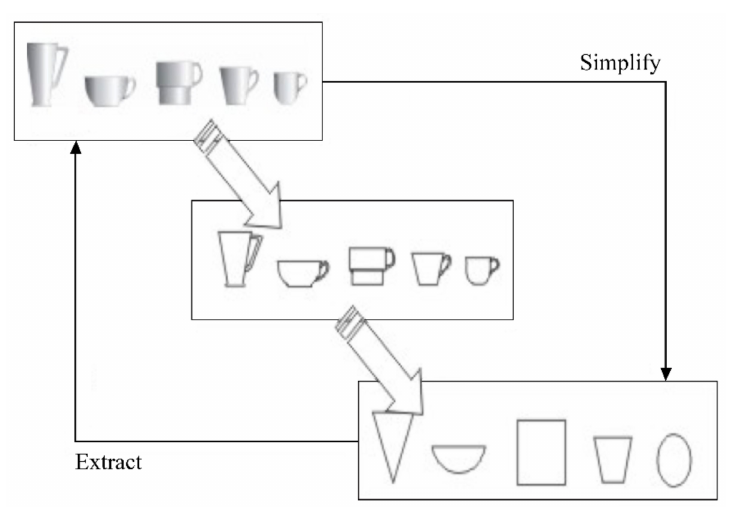
Figure 4. Part of form samples of coffee cup.